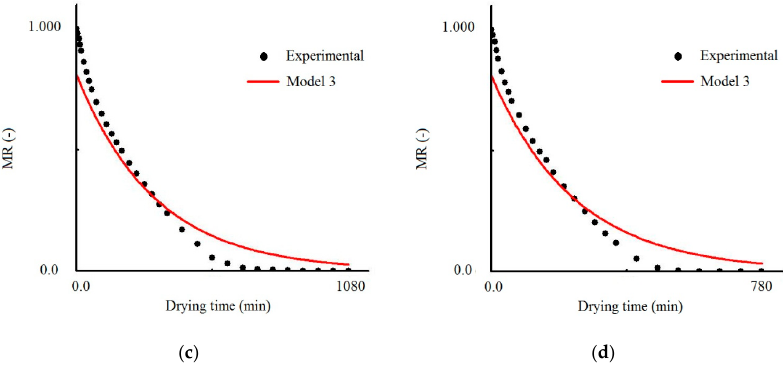
Figure 1. Comparison of dimensionless moisture contents obtained in the experiment and predicted using model 3 at drying air temperatures of ( a ) 50 °C, ( b ) 60 °C, ( c ) 70 °C and ( d ) 80 °C.